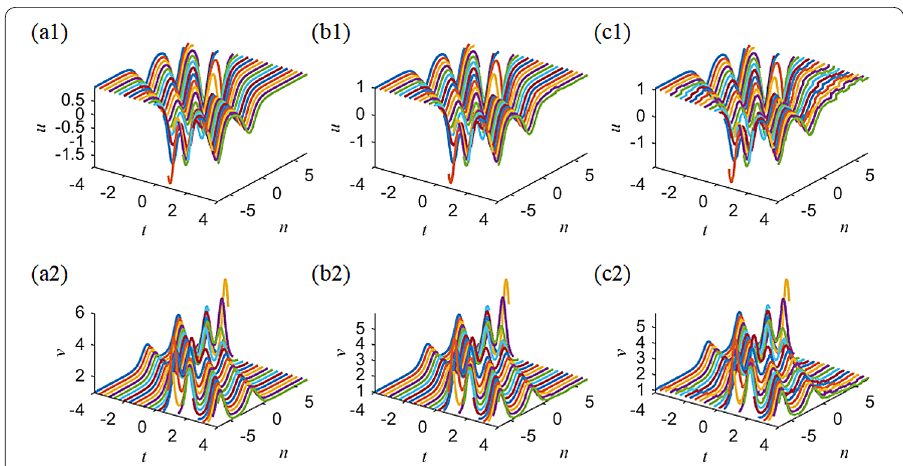
Figure 8 Four-soliton solution (45) with the same parameters as Fig. 3. ( a ) Exact solution; ( b ) Time evolution using exact solution (45) as an initial condition; ( c ) Time evolution using exact solution (45) perturbed by a 5% noise as the initial